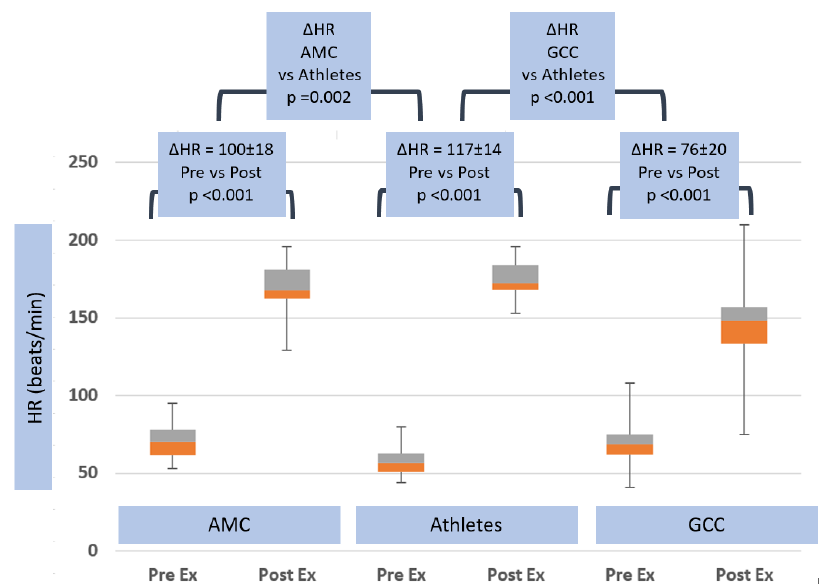
Figure 2. Heart rate response in age matched controls, athletes and general community cohort populations, pre- and post-exercise. The box and whisker plots depict the minimum, first quartile, median, third quartile and maximum values of each data set. The change in heart rate from pre- to post-exercise is shown for the three groups, with standard deviations and p -values. The change in heart rate between all groups is also shown, with p -value.